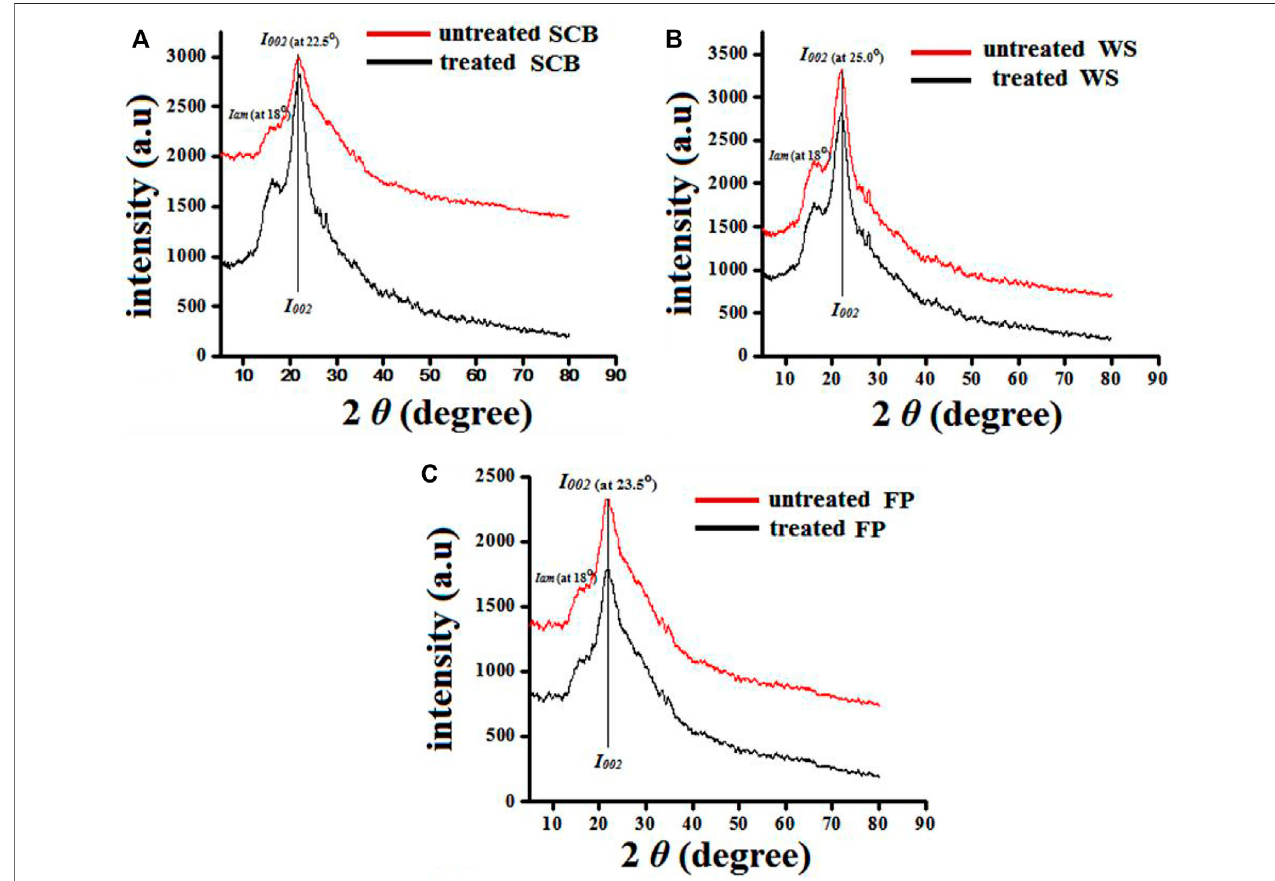
FIGURE 9 | X-ray diffraction analysis of untreated, SCB, WS, and FP [ (A – C) denoted in red] and enzyme-treated, SCB, WS, and FP [ (A – C) denoted in black] respectively.